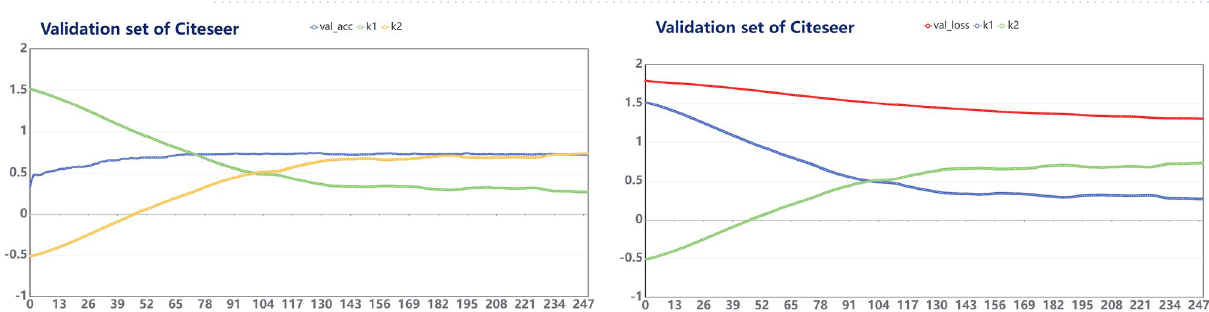
Figure 9. Citeseer: Fitting relationship between val_acc, val_loss and parameters.